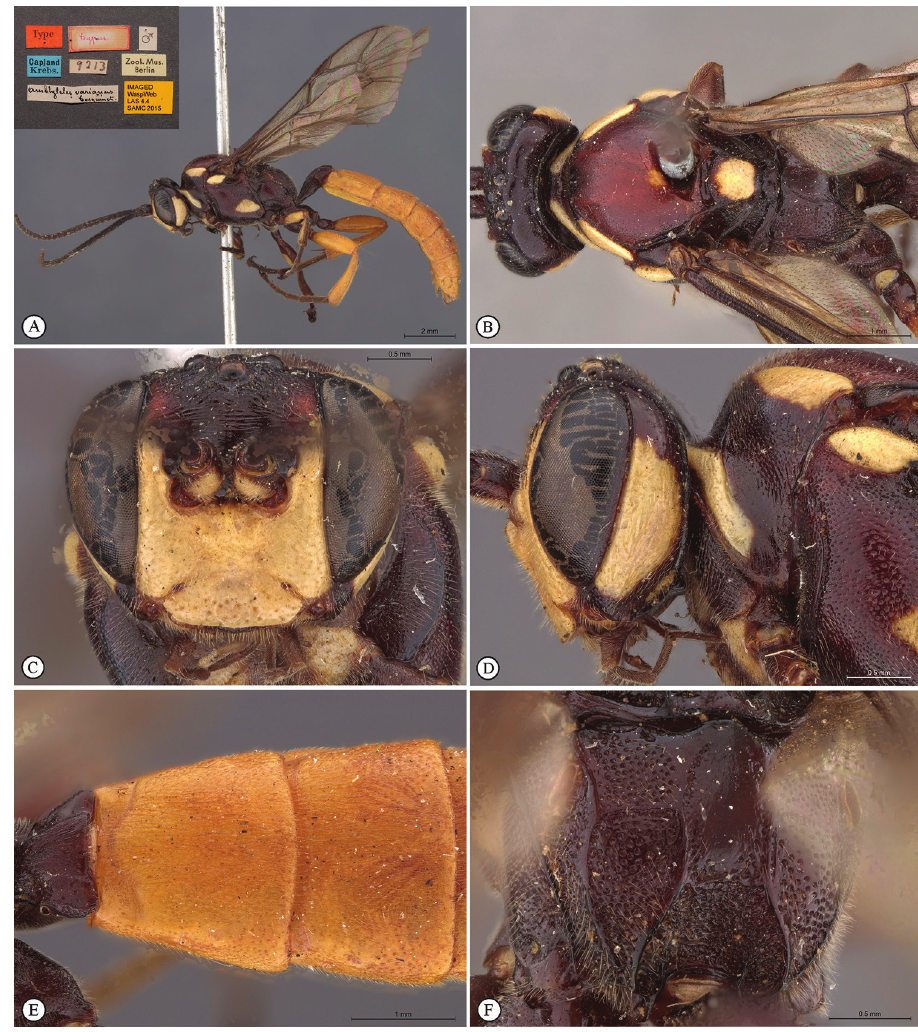
Figure 9. Genaemirum varianum (Tosquinet). Holotype male. A habitus lateral view (inset: data labels) B head, mesosoma, dorsal view C head anterior view D head, mesosoma anterior-lateral view E metasomal tergites 1-4 dorsal view F propodeum, dorsal